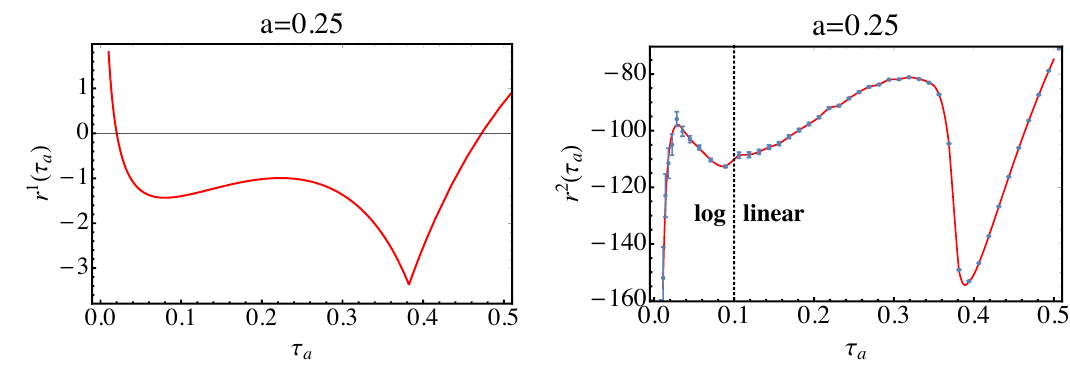
Figure 7 . Left: ( (cid:11) s ) remainder function for a = 0 : 25, which is known from [34]. Right: the O corresponding ( (cid:11) 2 ) remainder function from EVENT2 (data points) with a suitable interpolation s O as described in the